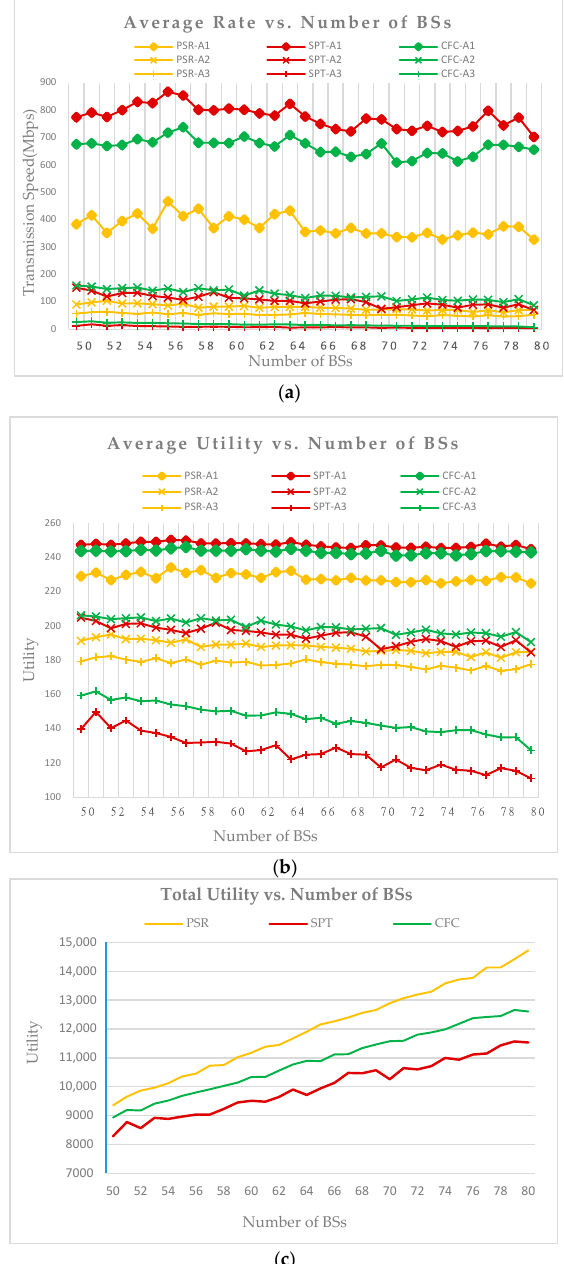
Figure 6. Performance of each area under different number of base stations (BSs): ( a ) data rate, ( b ) utility, ( c ) total utility.